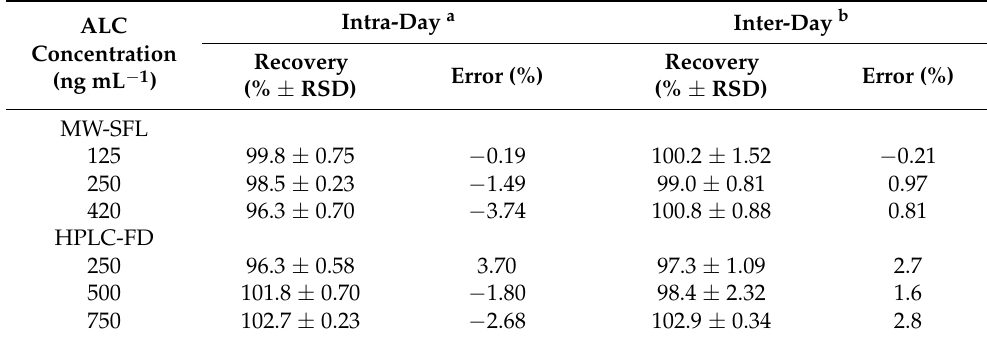
Table 4. The precision and accuracy of both the MW-SFL and the HPLC-FD methods for determination of